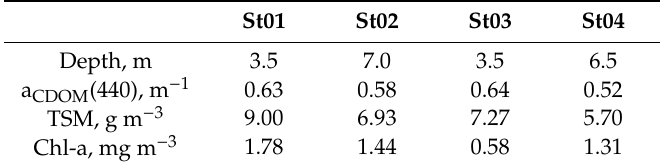
Table 1. Concentrations of optically active water color constituents for the Pakri field sites: